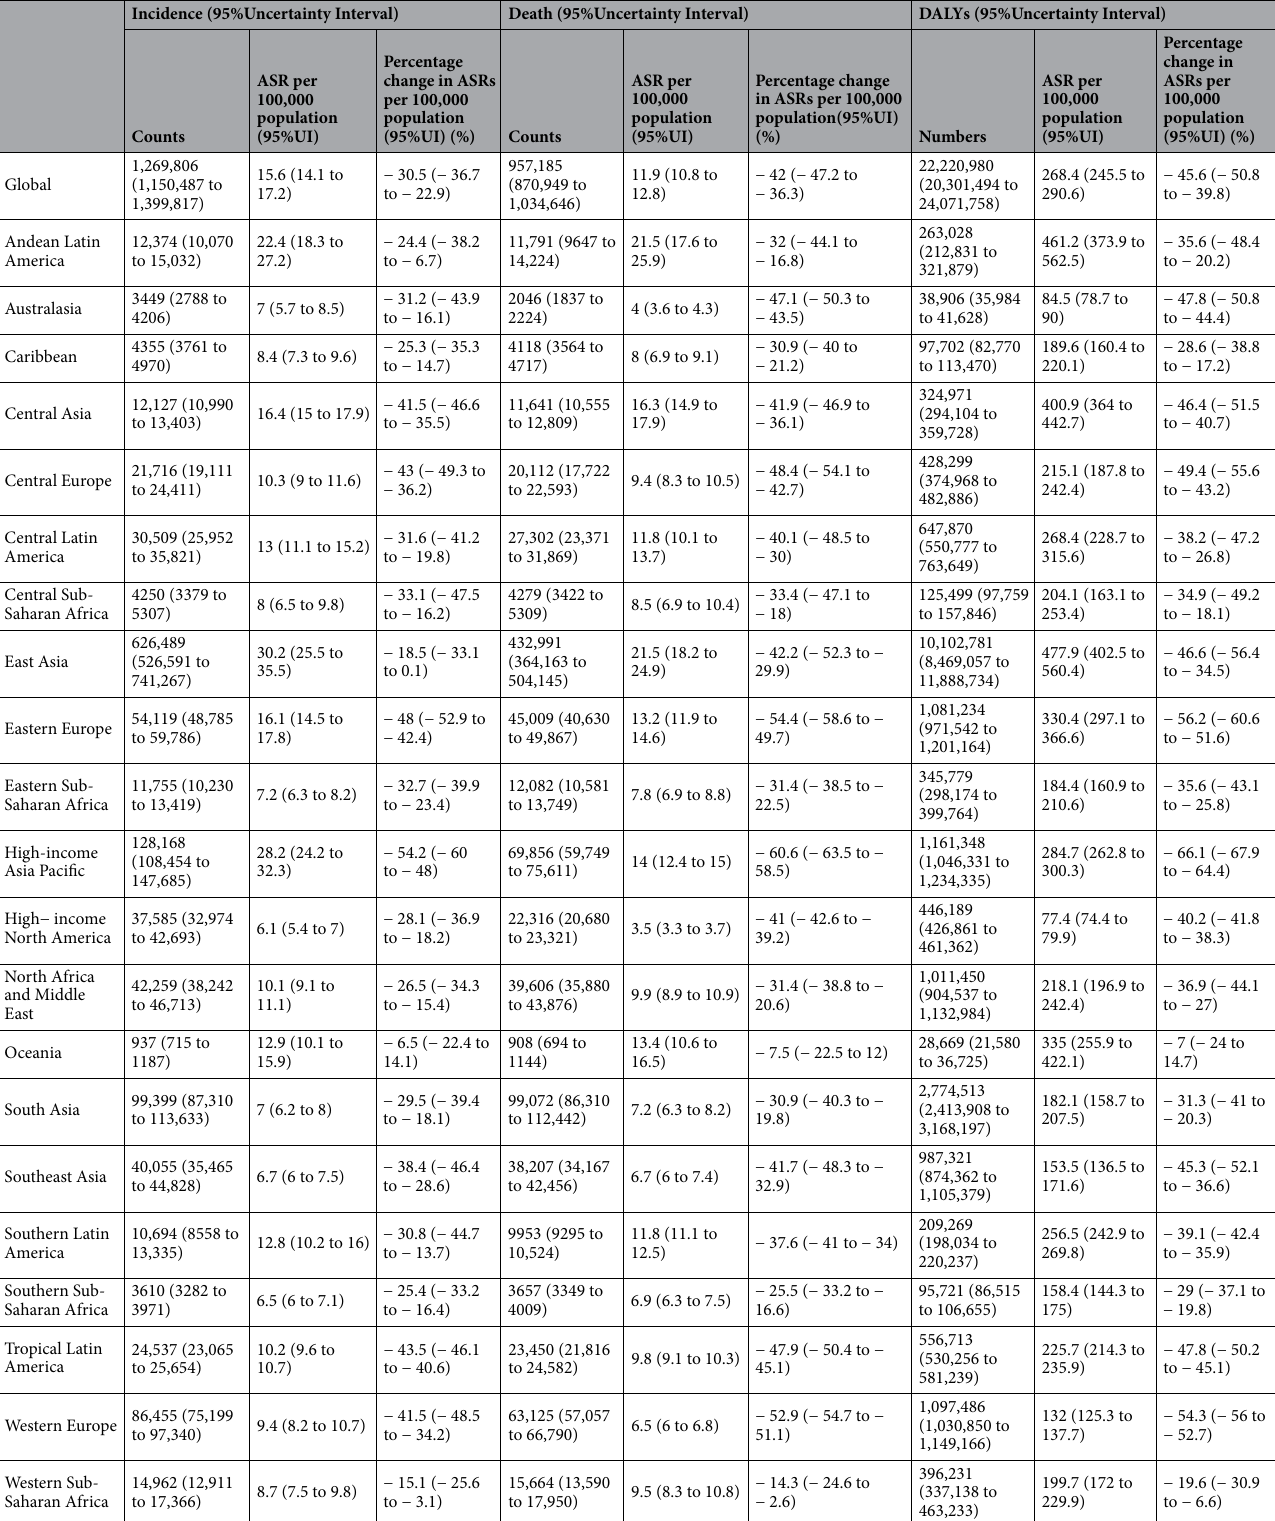
Table 1. The incidence, deaths and DALYs for stomach cancer in 2019 for both sexes, and percentage change of age-standardized rates (ASRs) by Global Burden of Disease regions from 1990 to 2019. DALYs disability adjusted life years, UI uncertainty